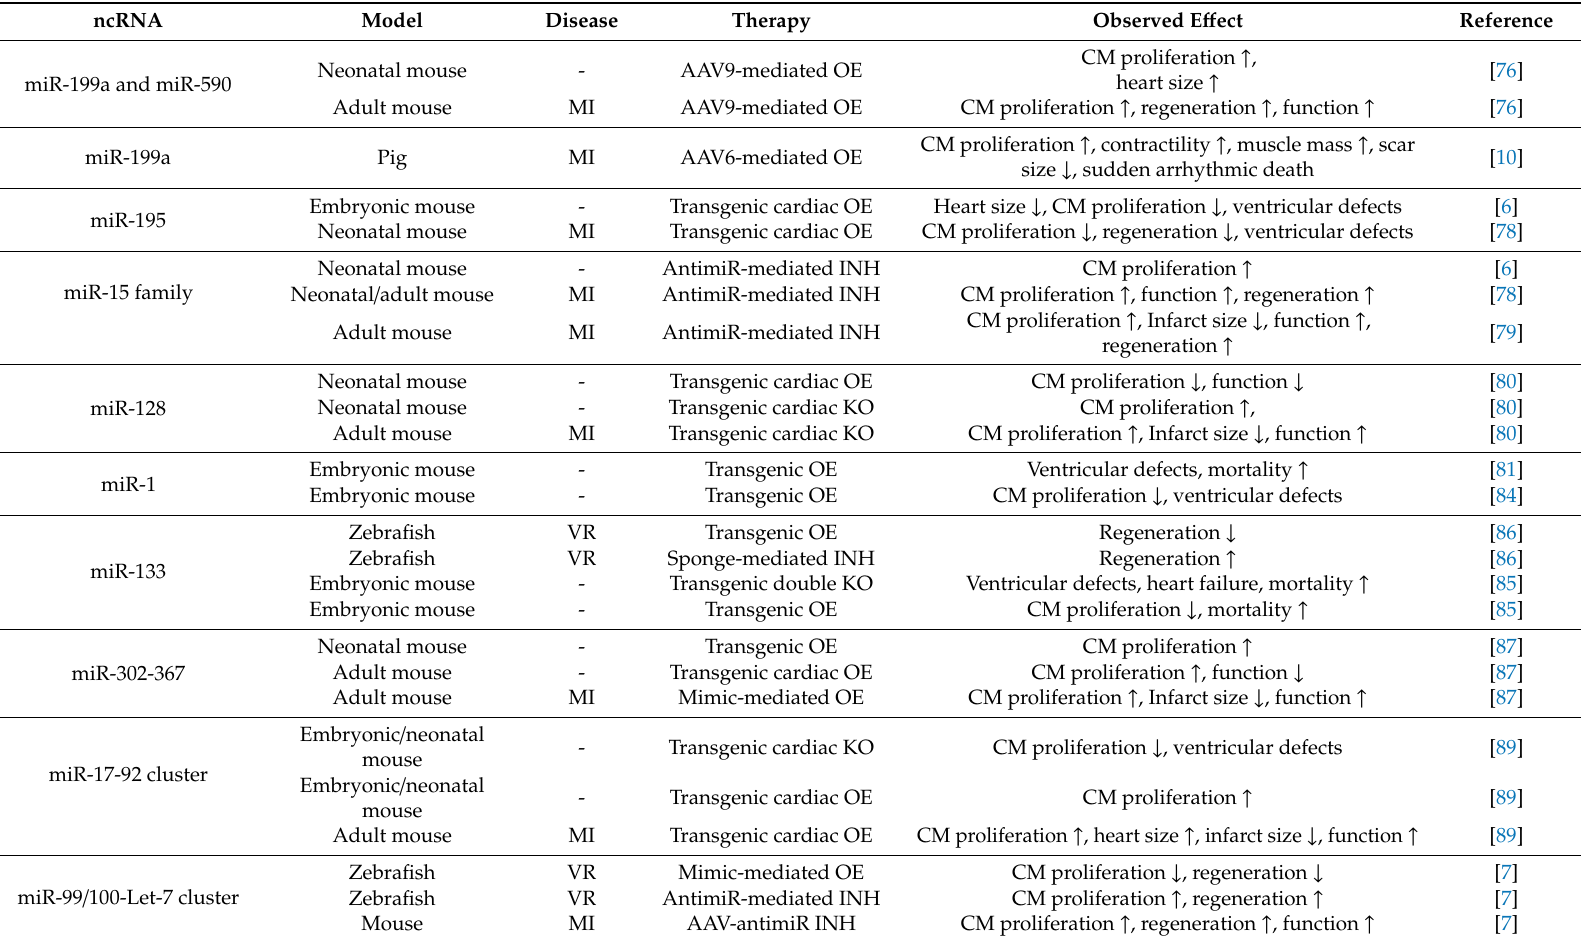
Table 1. MicroRNAs regulating cardiac regeneration through control of